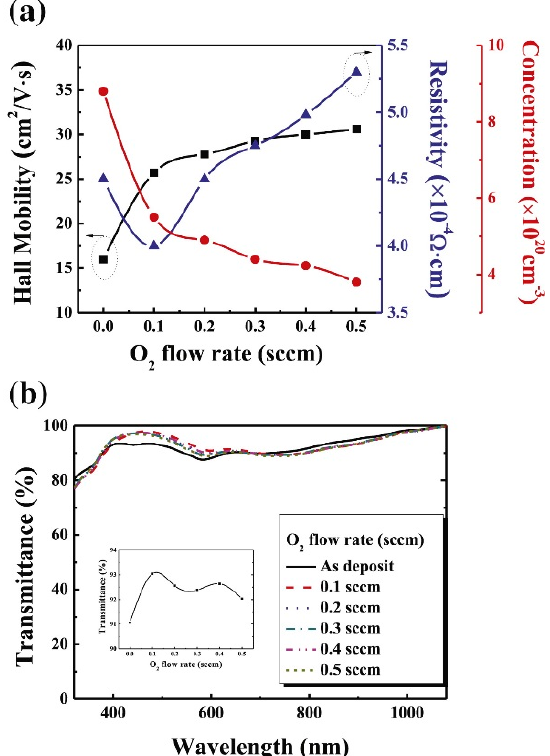
Figure 7. Correlation between ( a ) Hall mobility, resistivity, and carrier concentration and ( b ) optical transmittance of ITO films for different O 2 flow rates (reprinted with permission from ref. [38]; copyright form Elsevier order number 5492920712562).